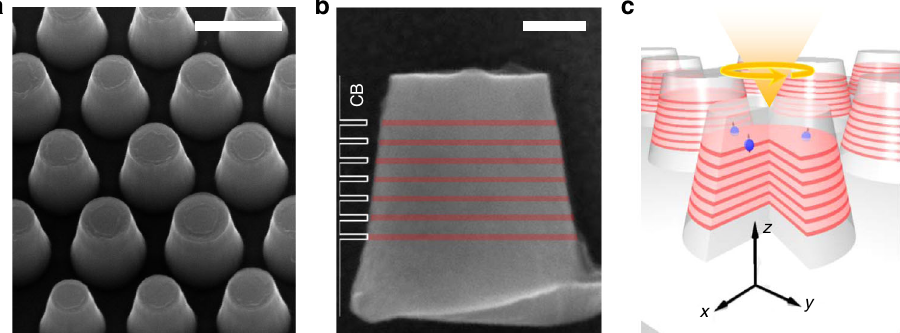
Fig. 1 GaNAs/GaAs nanodisk in nanopillar array design. a Scanning electron microscopy (SEM) image of the arrayed GaNAs nanodisk-in-GaAs nanopillars (DiP). b Side-view SEM image of an individual DiP, where the seven GaNAs nanodisks are shown in red color. The energy pro fi le of the conduction band (CB) edge along the nanopillar axis is indicated on the left side. The valence band edge is nearly unperturbed by N alloying or strain, and therefore its pro fi le is approximately fl at and not shown here. The scale bars in a and b denote 400 and 100 nm, respectively. c Schematic illustration of the experimental con fi